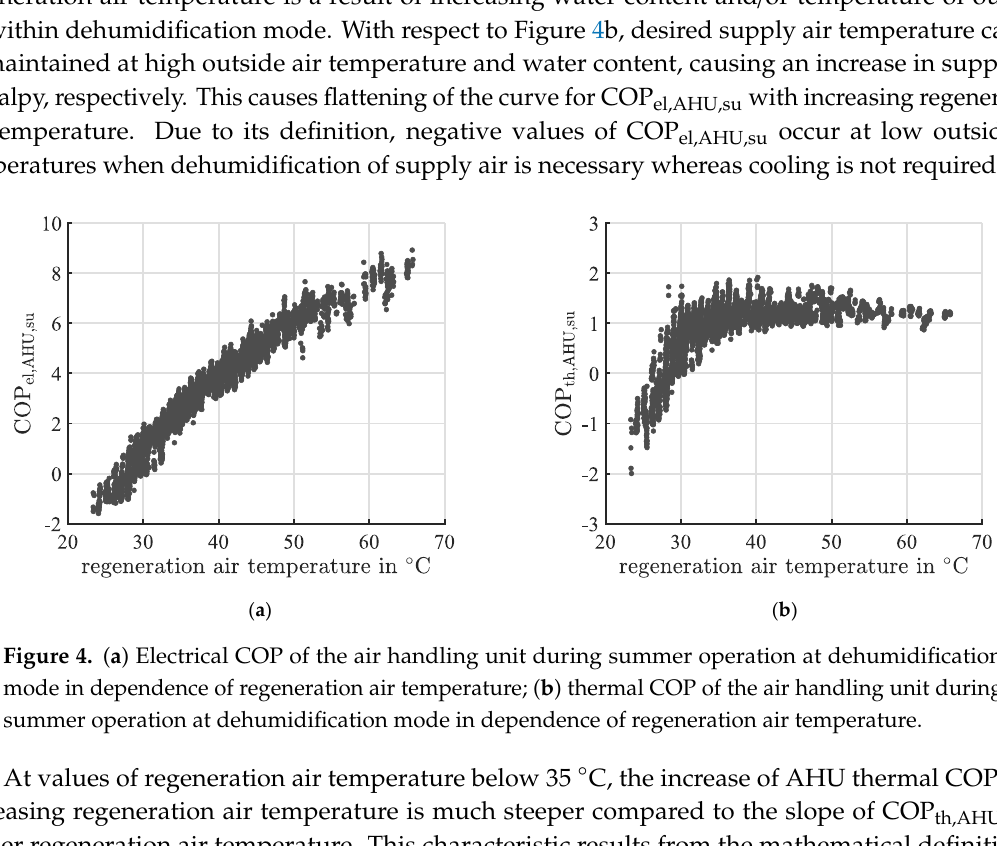
Figure 4. ( a ) Electrical COP of the air handling unit during summer operation at dehumidification